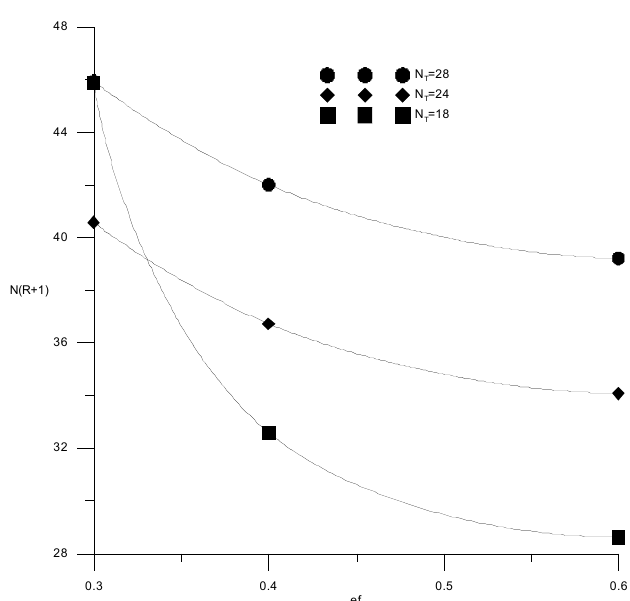
Figure 14. Capital costs for extractive rectification from the number of trays in the column at different flow rates of fresh extractant.